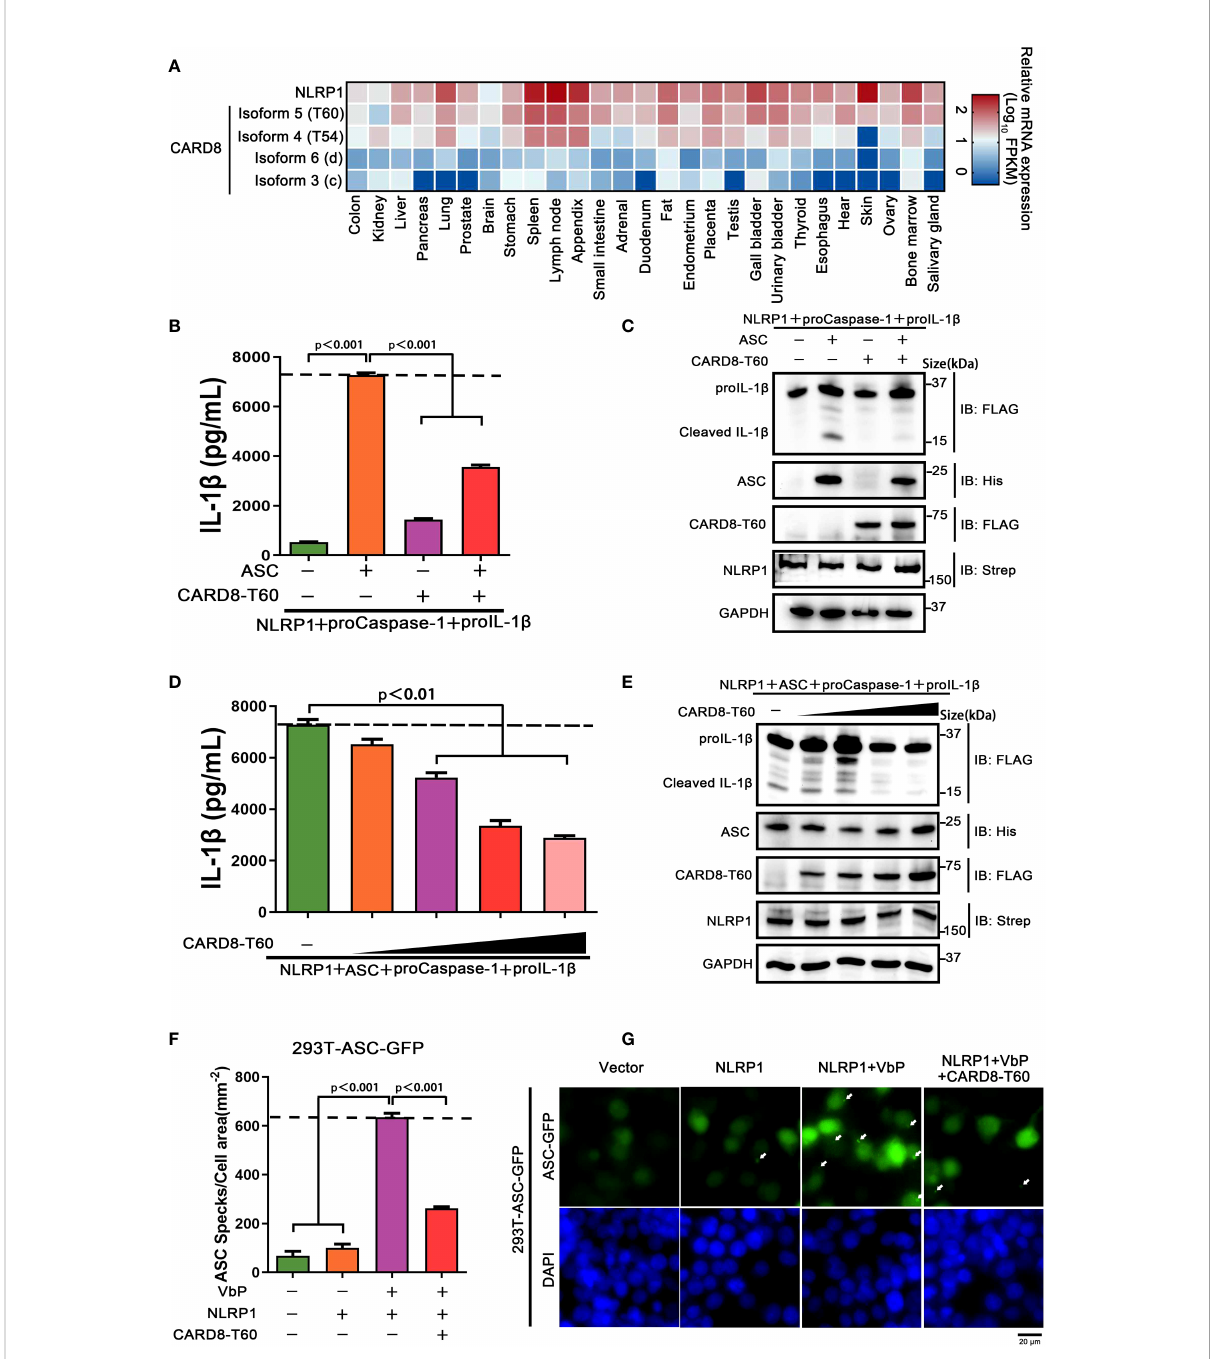
FIGURE 2 CARD8-T60 isoform suppresses NLRP1 in fl ammasome activation level. (A) Heat map of NLRP1 and CARD8 isoforms transcription expression levels in 27 kinds of tissues or organs in human body. (B, C) HEK 293T cells were transiently transfected with constructs encoding the proIL-1 b , proCaspase-1, ASC, NLRP1 and CARD8-T60. After 48 hours, ELISA and immunoblotting analysis were conducted with cell cultural supernatants and lysates. Data are shown as mean ± SEM and representative of three biological replicates. (D, E) HEK 293T cells were transiently transfected with proIL-1 b , proCaspase-1, ASC, NLRP1 and an increased concentration CARD8-T60 expression plasmids. After 48 hours, ELISA and immunoblotting analysis were conducted with cell cultural supernatants and lysates. Data are shown as mean ± SEM and representative of three biological replicates. (F, G) HEK 293T cells stably expressing ASC-GFP were transiently transfected with the indicated expression plasmids and treated with VbP (5 m M) for 6 hours. The cells were fi xed with 4% formaldehyde and evaluated for ASC speck formation by fl uorescence microscopy in three differential regions. Data of mean specks per cell area are shown as mean ± SEM in f and representative images are shown in